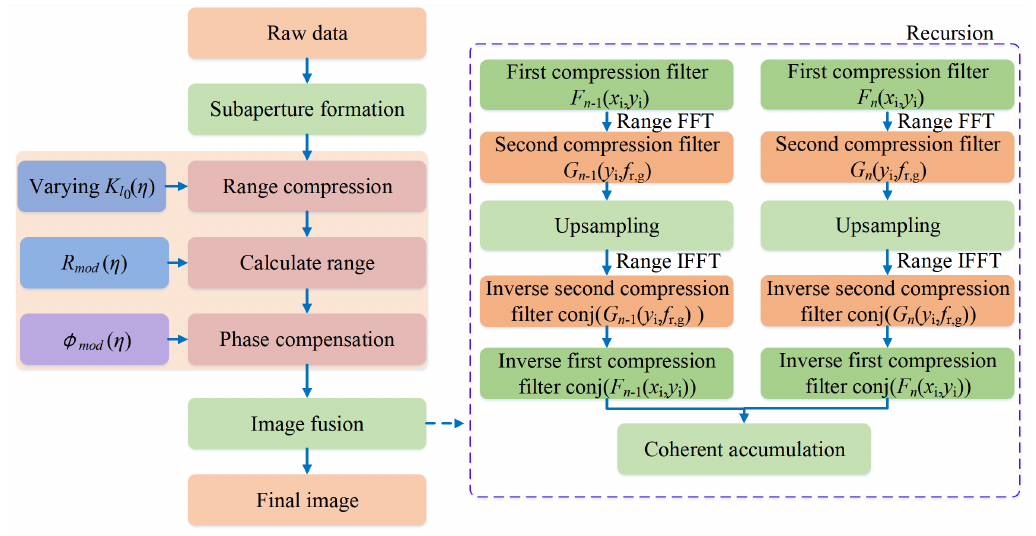
Figure 3. The processing flow of the proposed algorithm.